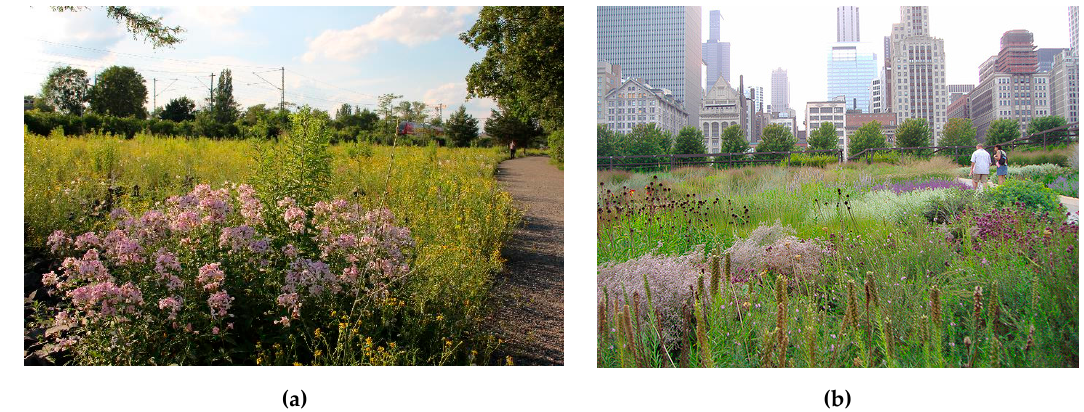
Figure 12. Spontaneous lawn in Gleisdreieck Park, Berlin ( a ), and the latest inspiration in the US: Lurie Garden with prairie plants in Millennium Park, Chicago ( b ). Photos: M. Ignatieva.